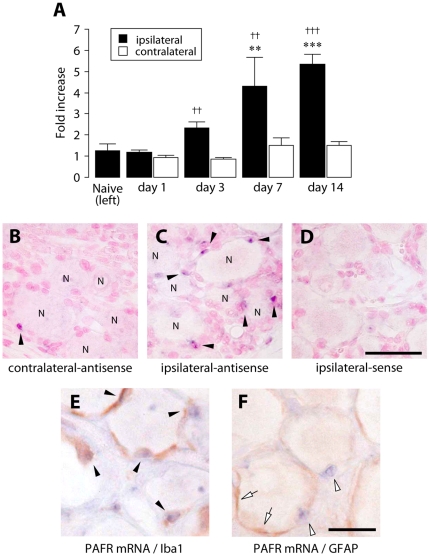
PAFR mRNA is upregulated in the DRG following peripheral nerve injury.A. Real-time PCR analysis revealed that PAFR mRNA expression in total RNA extract from the L5 DRG was markedly increased after peripheral nerve injury. The bar graphs show the average fold increase in the level of PAFR mRNA expression in the DRG compared with the mean expression level of PAFR mRNA in naïve rats. Each measurement was normalized to GAPDH content. **p<0.01, ***p<0.001 compared with naïve rats. ††p<0.01, †††p<0.001 compared with the contralateral side. All data are presented as mean ± SEM of five individual animals. B-D. DIG-labeled antisense (B: contralateral, C: ipsilateral) and sense (D: ipsilateral) probes specific for PAFR mRNA were visualized by in situ hybridization in the rat DRG 7 days after nerve injury. Strong PAFR mRNA signals were observed in the cells surrounding DRG neurons in the ipsilateral DRG 7 days after nerve injury. Arrowheads show PAFR mRNA-positive cells. ‘N’ indicates neuronal cells. Similar results were observed in each of three experiments. Scale bar, 50 µm. E,F. In situ hybridization combined with immunohistochemistry for the macrophages/microglia marker Iba1 and the satellite glia marker GFAP was performed. PAFR mRNA signals overlapped with Iba1-IR (arrowheads, E) but not with GFAP-IR (GFAP: white arrowheads, PAFR: white arrows, F). Scale bar, 25 µm.